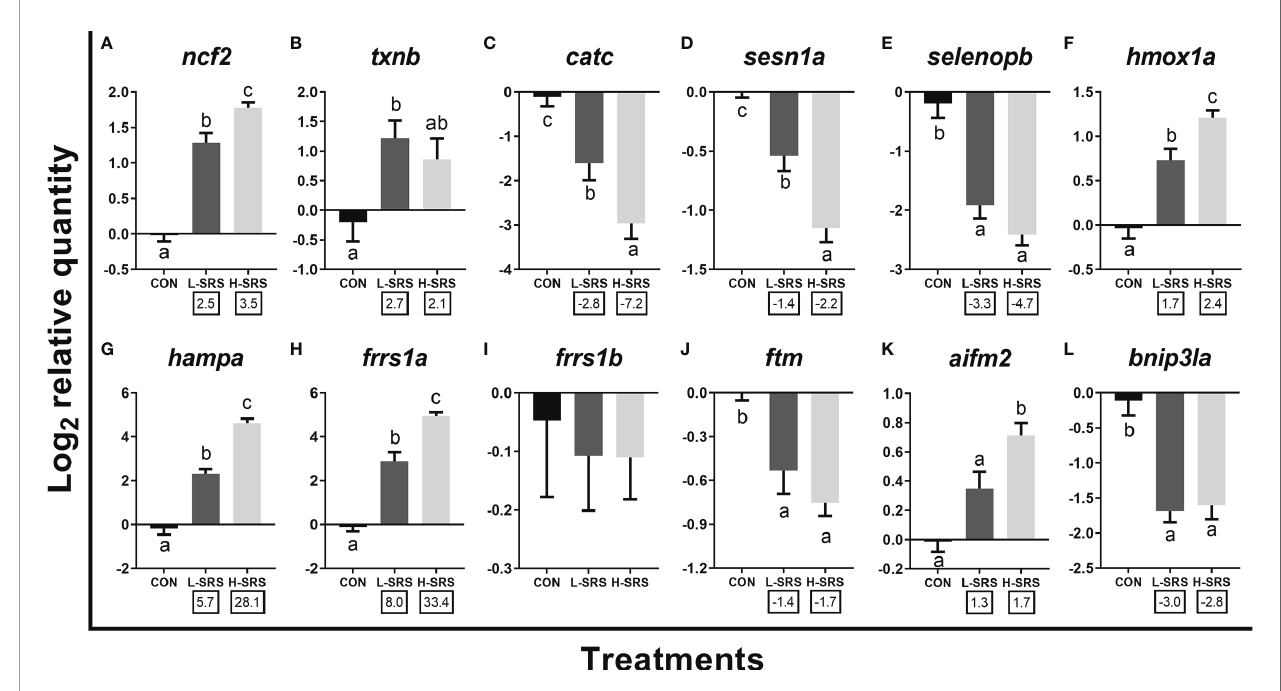
FIGURE 8 | qPCR analysis of P. salmonis -responsive genes involved in redox homeostasis and other cellular processes. Fish with lower (L-SRS; n = 10) and higher (H- SRS; n = 16) level of P. salmonis infection at 21 days post-injection (DPI) as well as time-matched control (CON; n = 8) were used for qPCR con fi rmation. Average log 2 RQs with SE bars are plotted. Different letters represent the signi fi cant differences among treatments ( p < 0.05) with fold-change relative to control indicated below the x-axis. For qPCR fold-change calculation, overall fold up-regulation was calculated as 2 A-B , where A is the mean of log 2 RQ from the L-SRS or H-SRS groups, and B is the mean of log 2 RQ from the CON group. For down-regulated transcripts, fold-change values were further inverted (-1/fold-change). (A) neutrophil cytosol factor 2 ; (B) thioredoxin b ; (C) catalase c ; (D) sestrin-1a ; (E) selenoprotein p b ; (F) heme oxygenase 1a ; (G) hepcidin a ; (H) ferric-chelate reductase 1a ; (I) ferric-chelate reductase 1b ; (J) ferritin, middle subunit ; (K) apoptosis inducing factor mitochondria associated 2 ; (L) BCL2/adenovirus E1B 19 KDa protein-interacting protein 3-like a